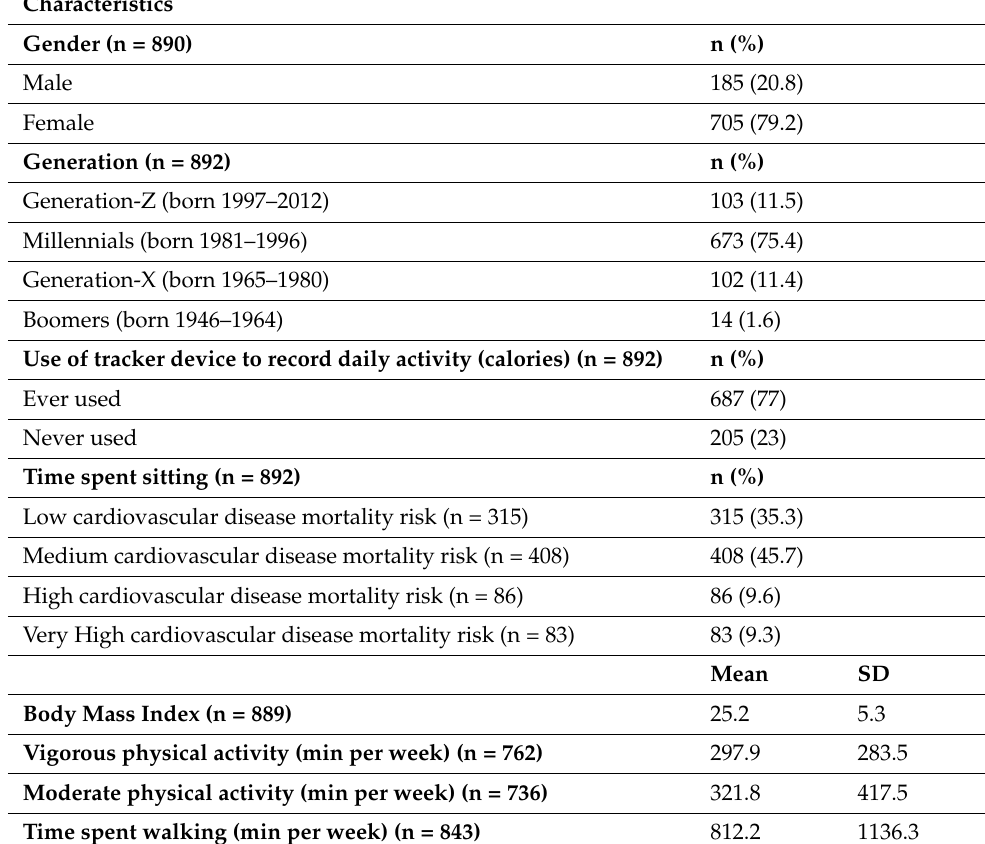
Table 2. Descriptive characteristics of the